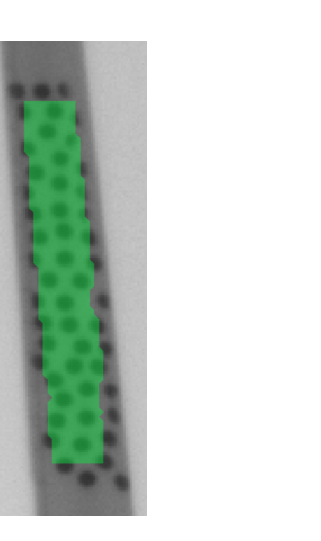
Figure 7. Measurement points plotted on the rotor blade.